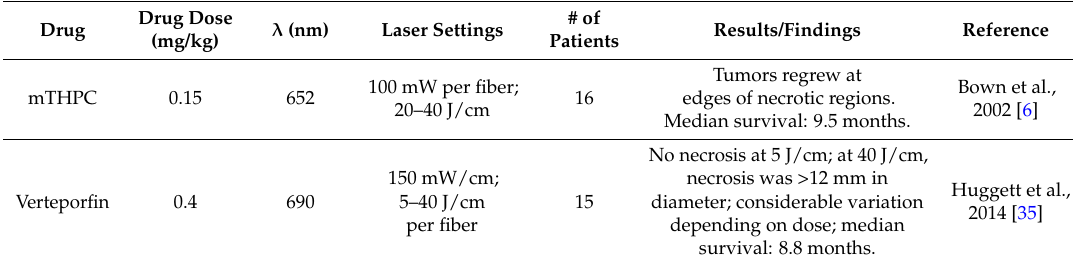
Table 2. Representative I-PDT treatments for pancreatic